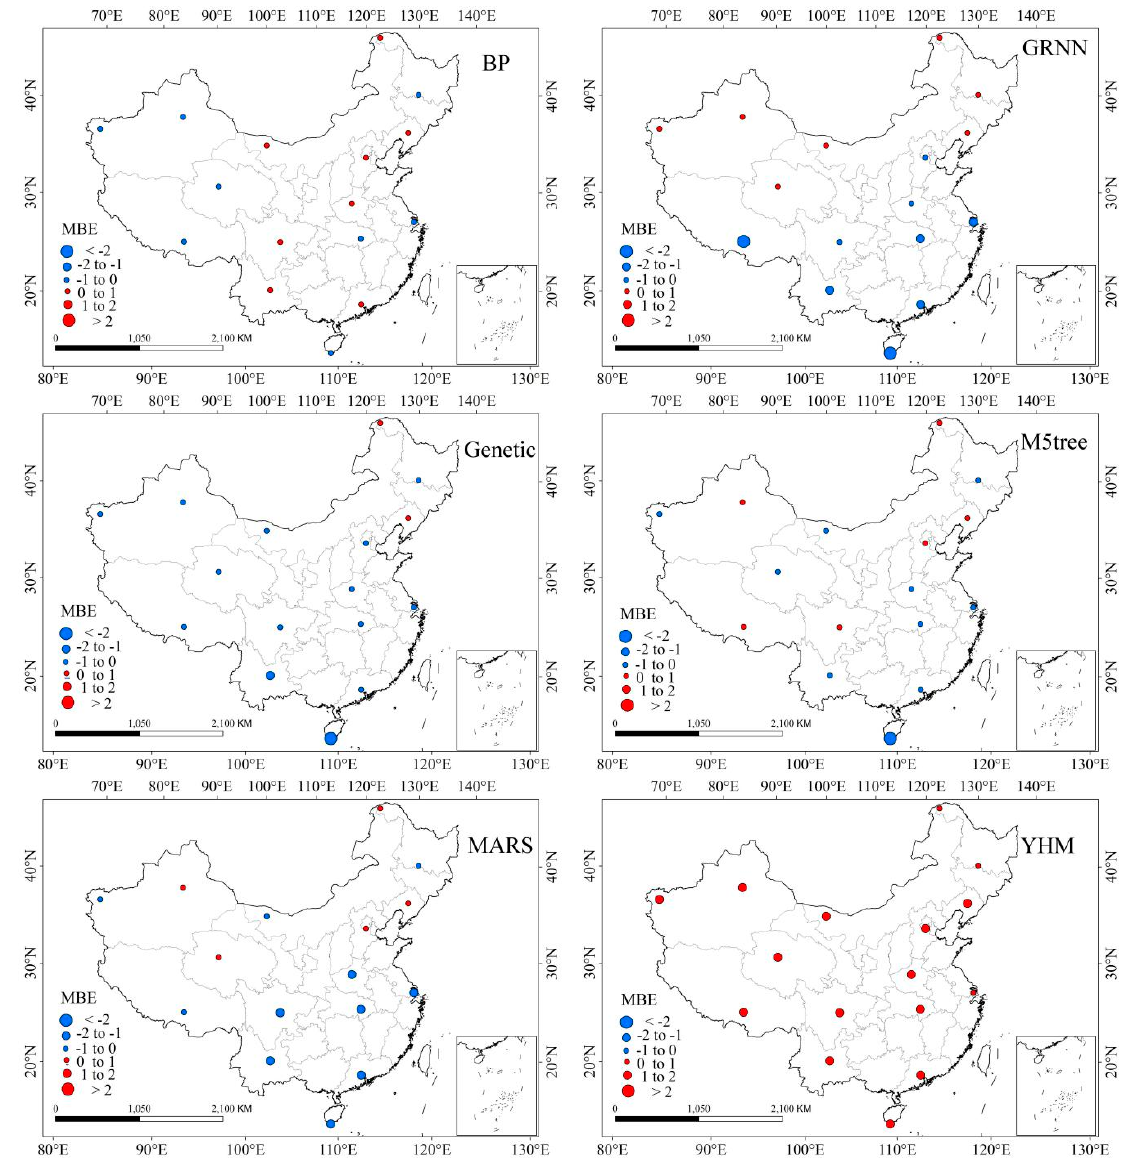
Figure 5. Spatial variation of the mean bias errors ( MBE) for the six DHI models.